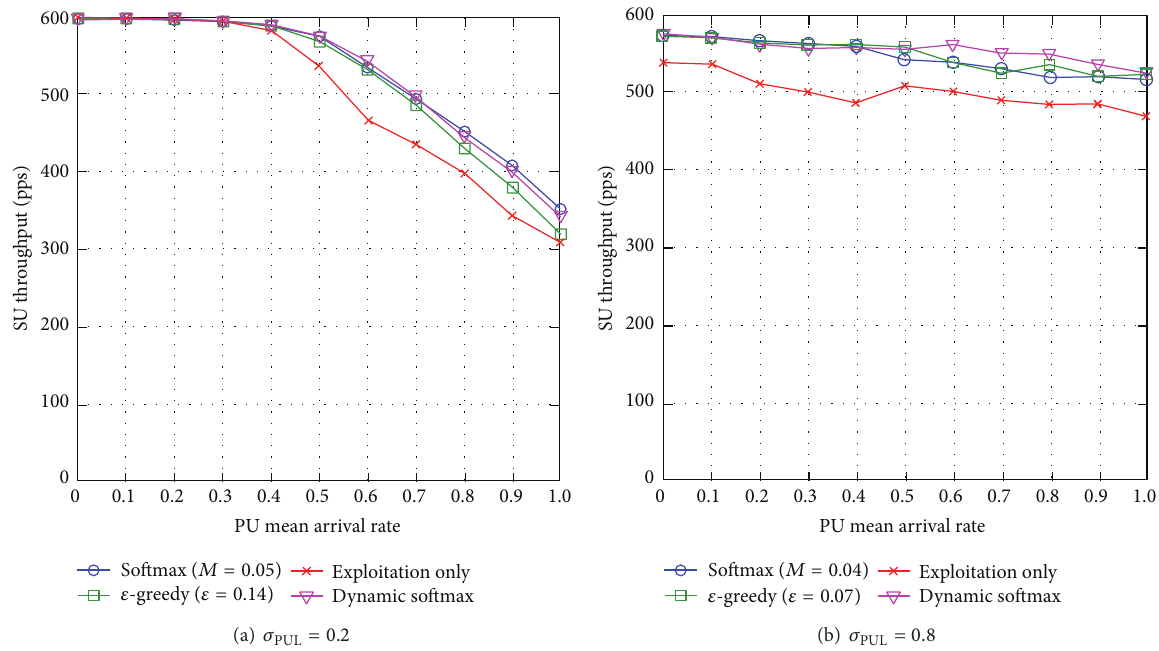
for different levels of standard deviation of PUL 𝜎 PUL